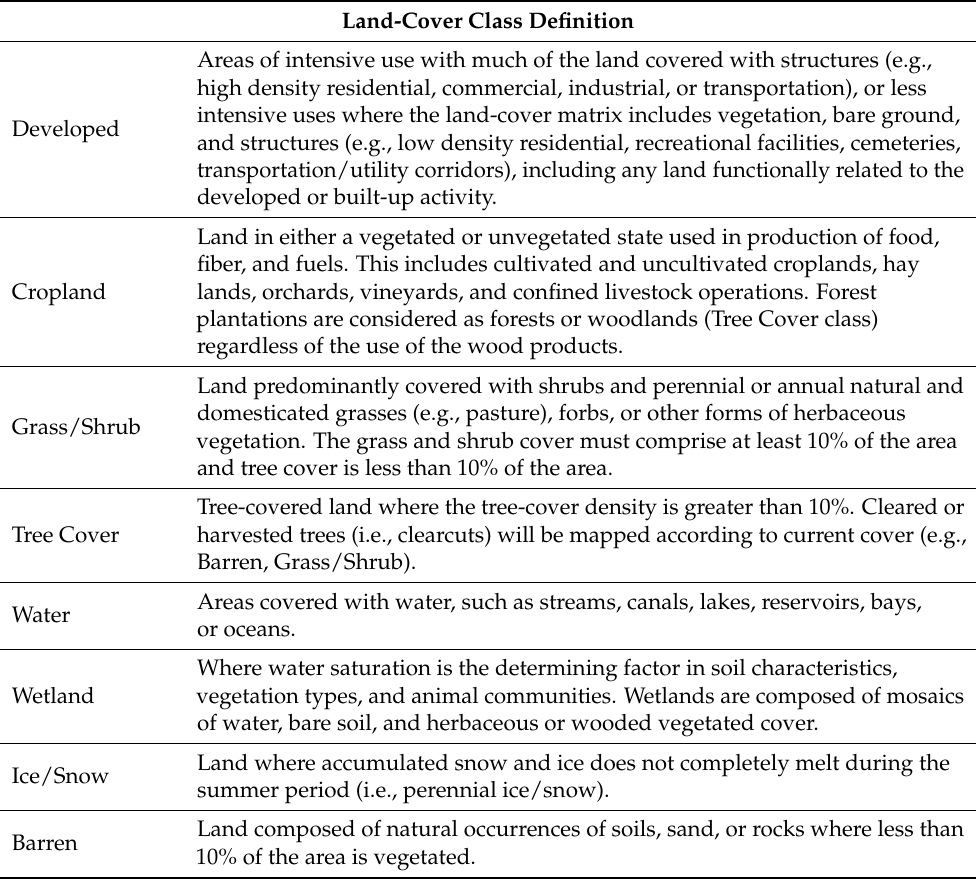
Table A1. LCMAP land-cover class definitions